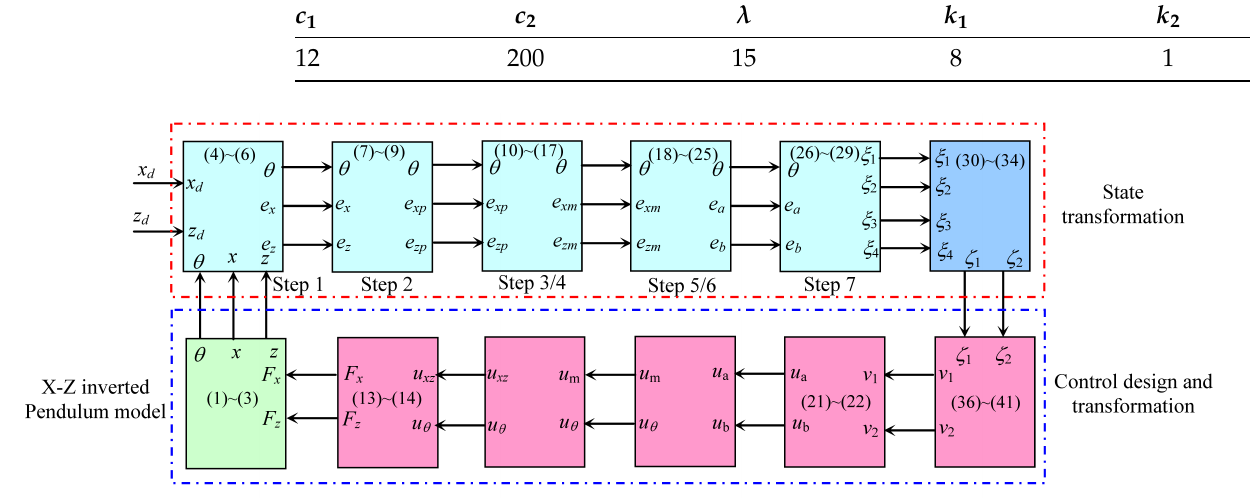
Table 2. Parameters of the tracking controller.